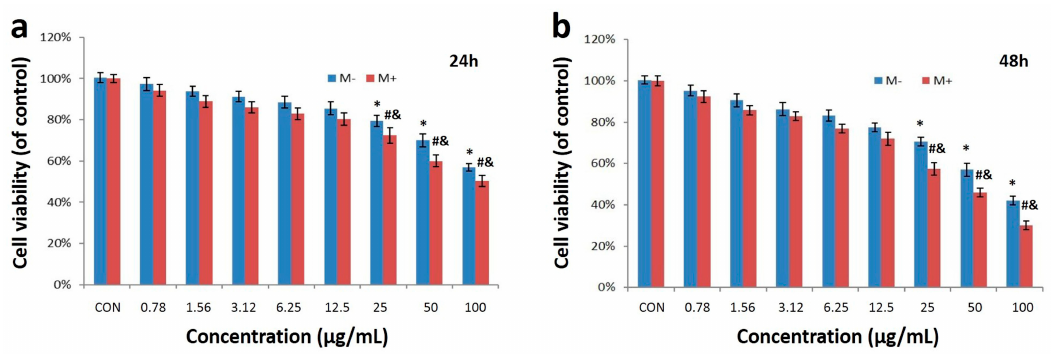
Figure 3. Cytotoxicity of Fe 3 O 4 @Au NPs to HeLa cells after 24 h ( a ) and 48 h ( b ). *, #, & p < 0.05 versus control group, & p < 0.05 versus non-magnetic treated-group.